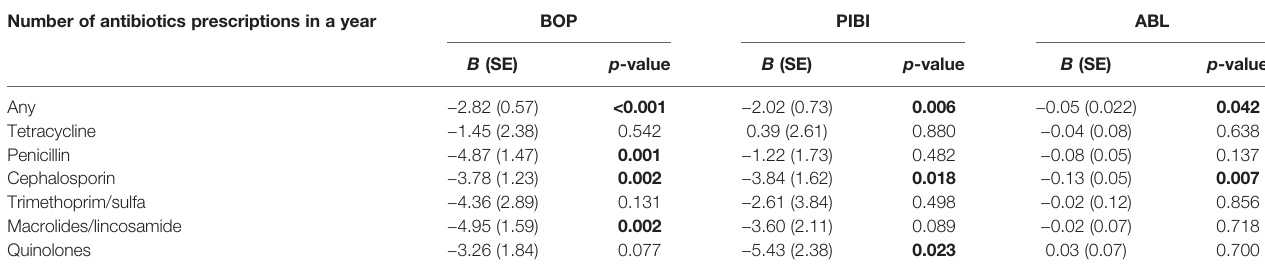
TABLE 2 | Association of antibiotic use with periodontal parameters. Number of antibiotics prescriptions in a year